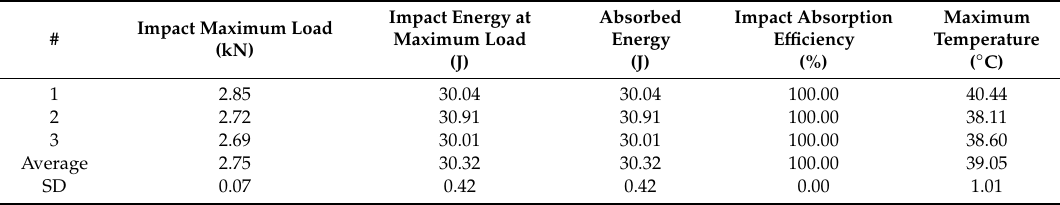
Figure 6. Impact test results of Type 4: ( a ) changes in load and energy with time, ( b ) impact load and displacement curve, ( c ) changes in temperature with time, ( d ) impact test of specimen Type 4, and ( e ) IR image of impact test (Type 4). Table 8. Impact test results of Type